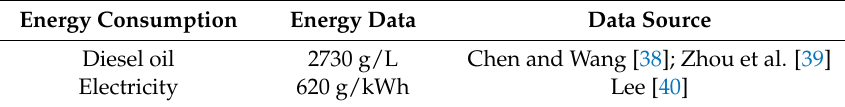
Table 2. The inventory carbon emission conversion coefficients.